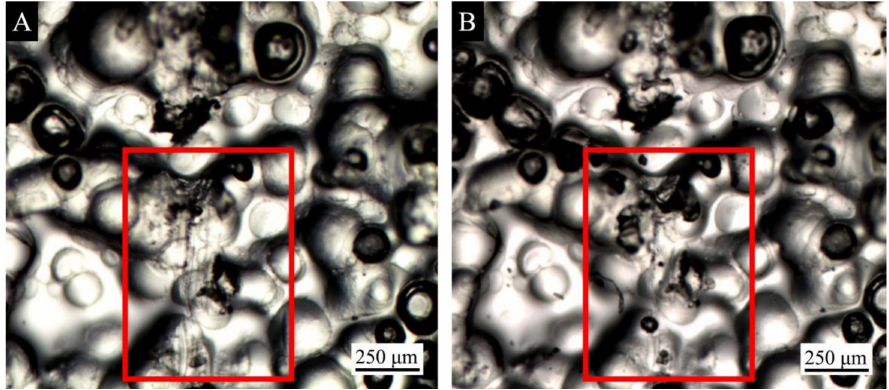
Figure 12. Comparison of a coating before and after microcapsule repair: ( A ) Before repair and ( B ) after